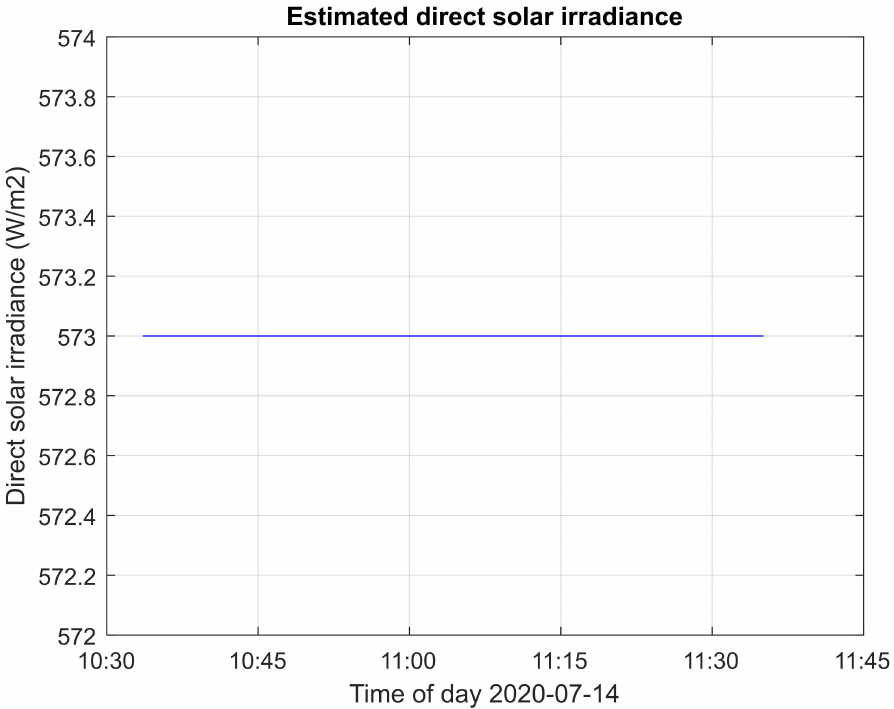
Figure 22. Predicted level of direct solar irradiance on 14 July 2020 from 10:30 until 11:45.